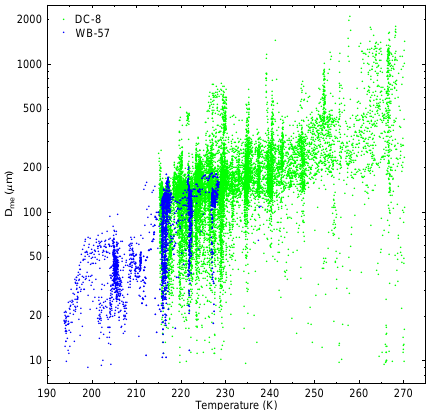
Fig. A3. Scatterplot of D me versus temperature for in situ size dis- tributions from the DC-8 and from the WB-57. The clusters of sam- ples at particular temperatures are due to extended flight segments at particular altitudes.